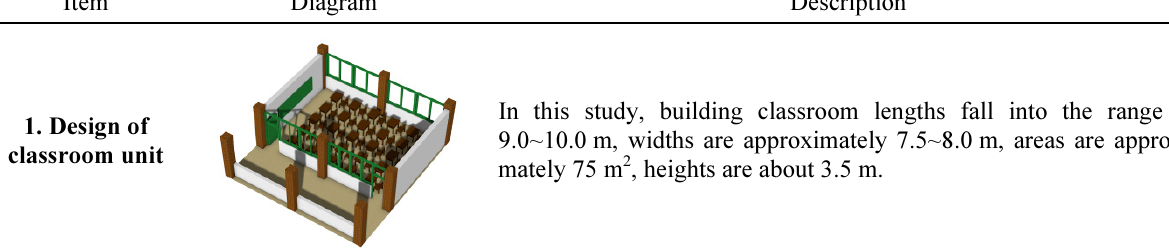
Table 2. The architectural characteristics of school buildings in Taichung City Item